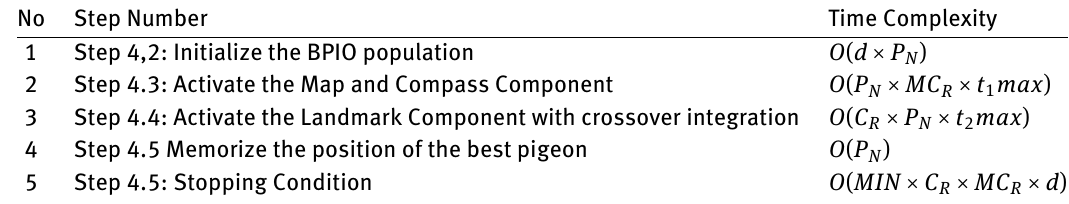
Table 1: Time complexity of each step in the proposed Modified BPIO